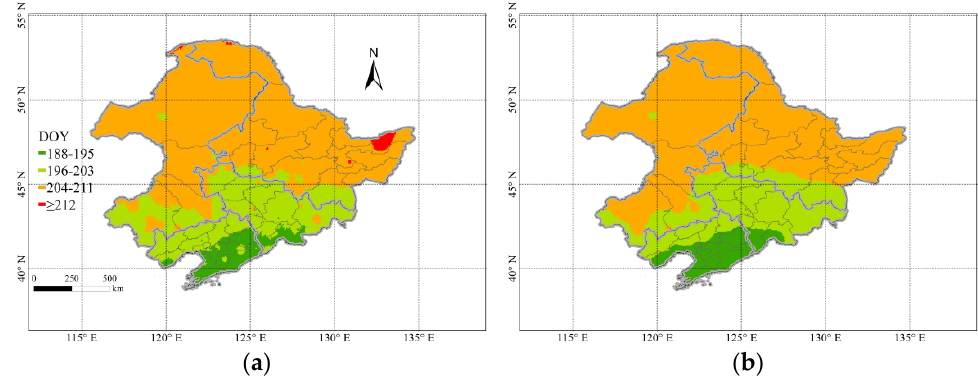
Figure 8. Maize tasseling stage (VT) in Northeast China (( a ) fusion data; ( b ) original data).